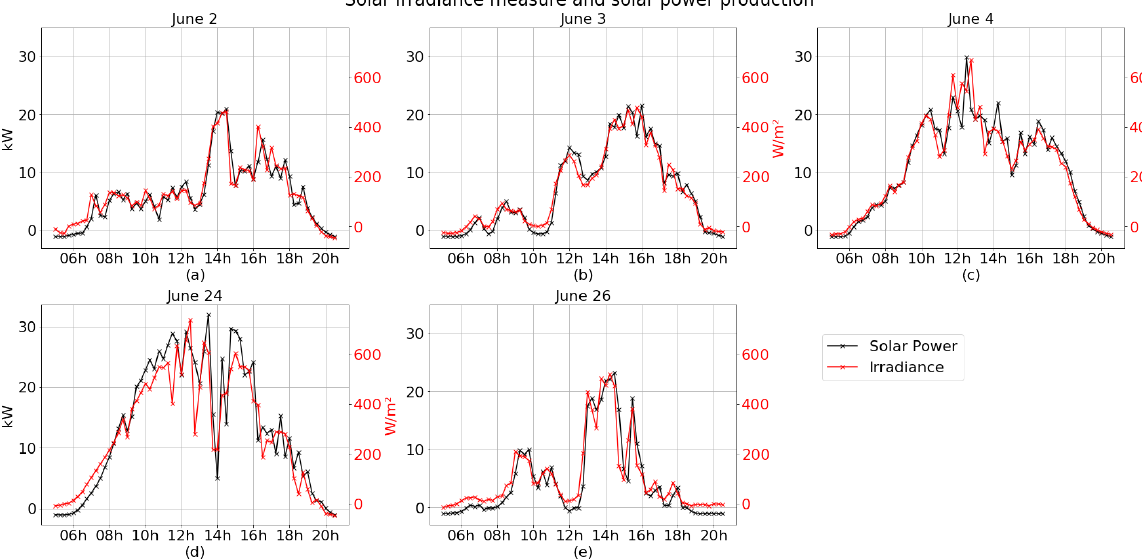
Figure 7. Solar irradiance measure from the Argonne meteorological sensor tower and solar power product from the Argonne Energy Plaza. The two locations are 1380 m apart in a straight line geographically. The results are shown for the cloud types ( a ) clear sky, ( b , c ) haze clouds, ( d ) partially cloudy sky, and ( e ) overcast.